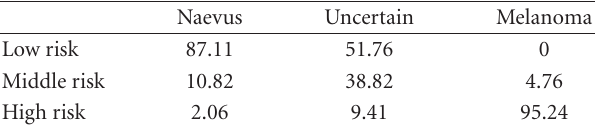
Table 2: Hit ratio of risk index computation. Naevus